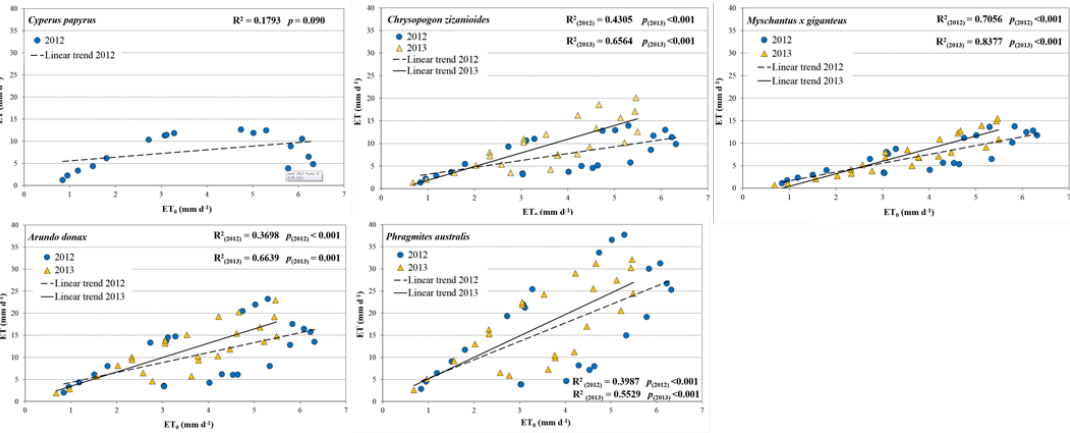
Figure 8. Relationship between ET 0 and ET for C. papyrus , C. zizanioides , M. giganteus , A. donax, and P. australis in 2012 and 2013 observation periods.